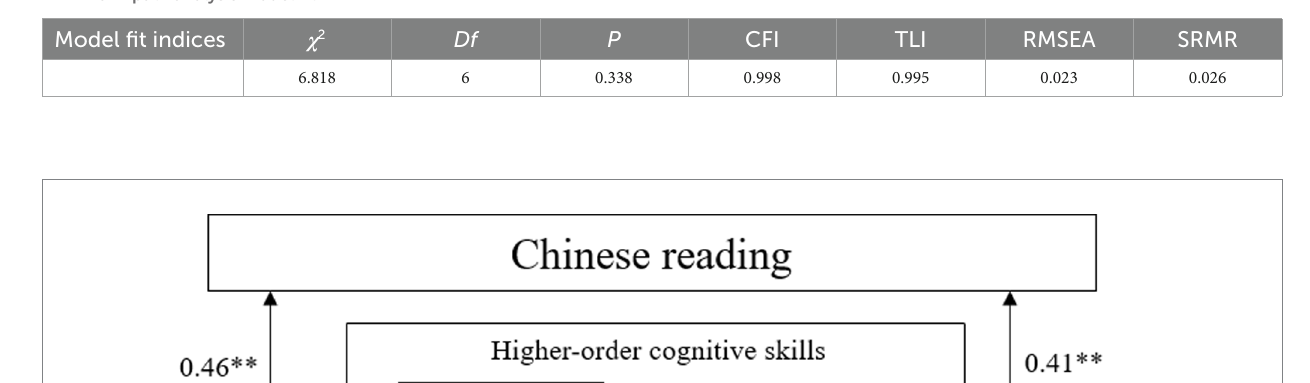
TABLE 3 A path analysis model fit.